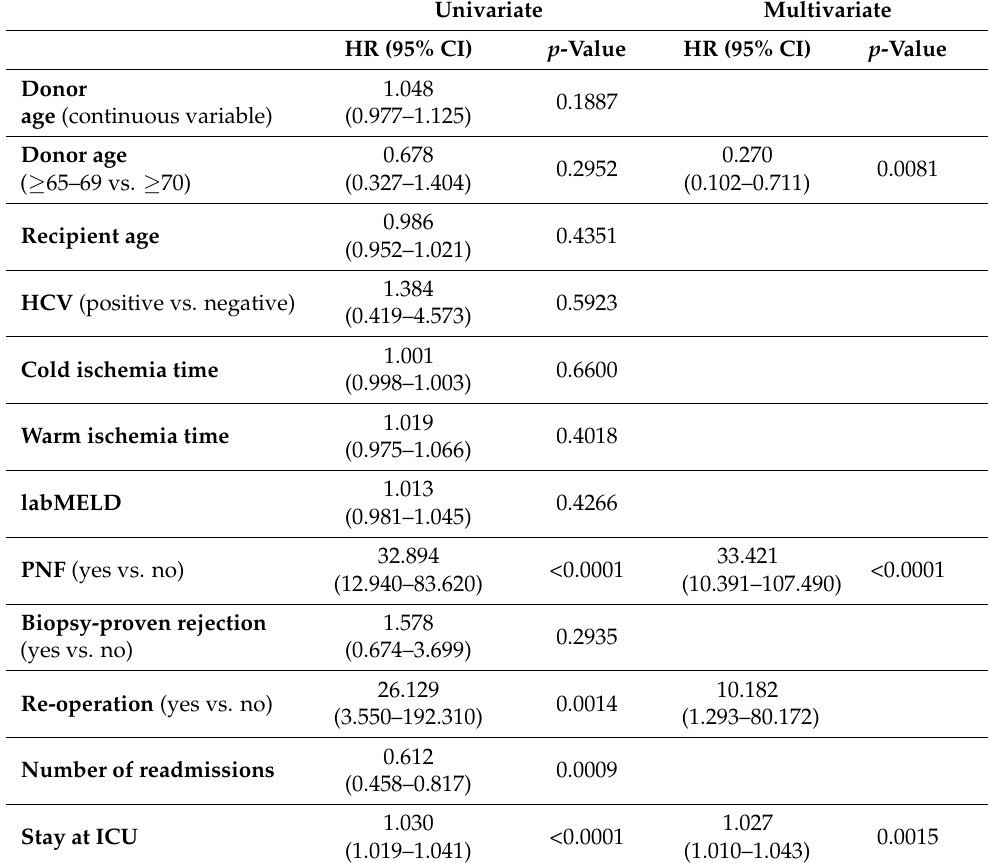
Table 7. Cox proportional hazards regression model with univariate and multivariable Cox regression analyses of one-year death-censored graft